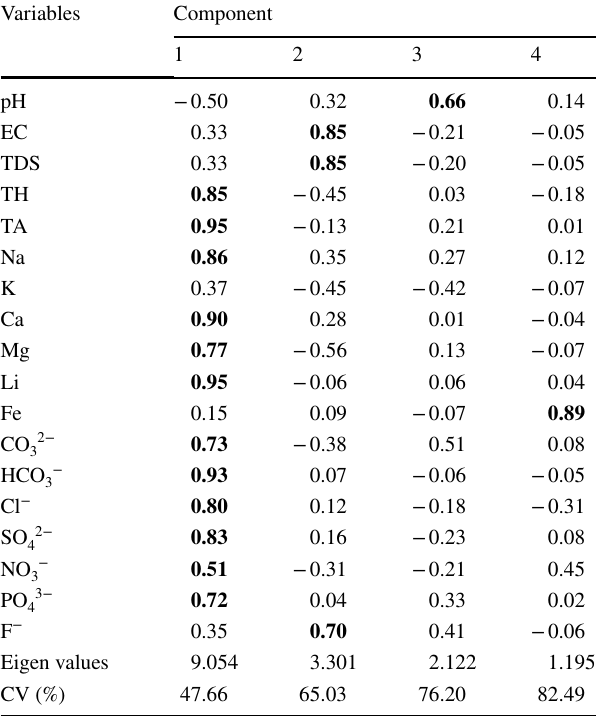
Table 4 Principal component analysis of observed parameters in the present study